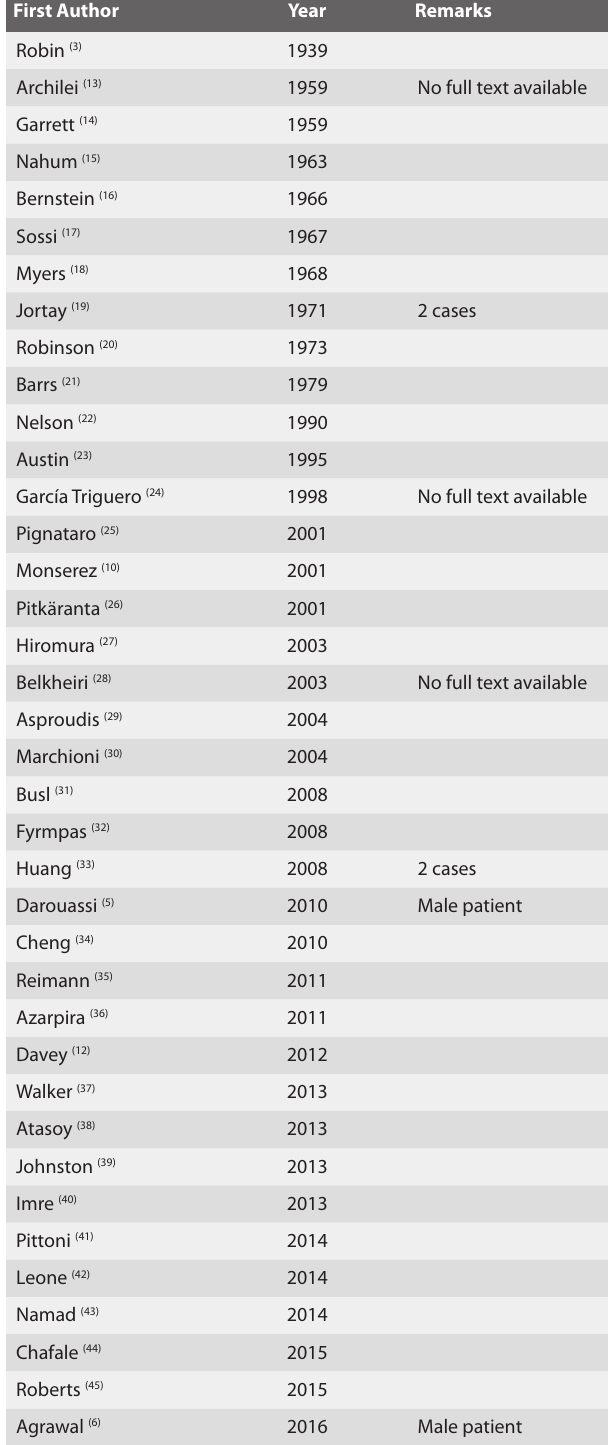
Table 1. Reports of breast cancer metastases to the paranasal